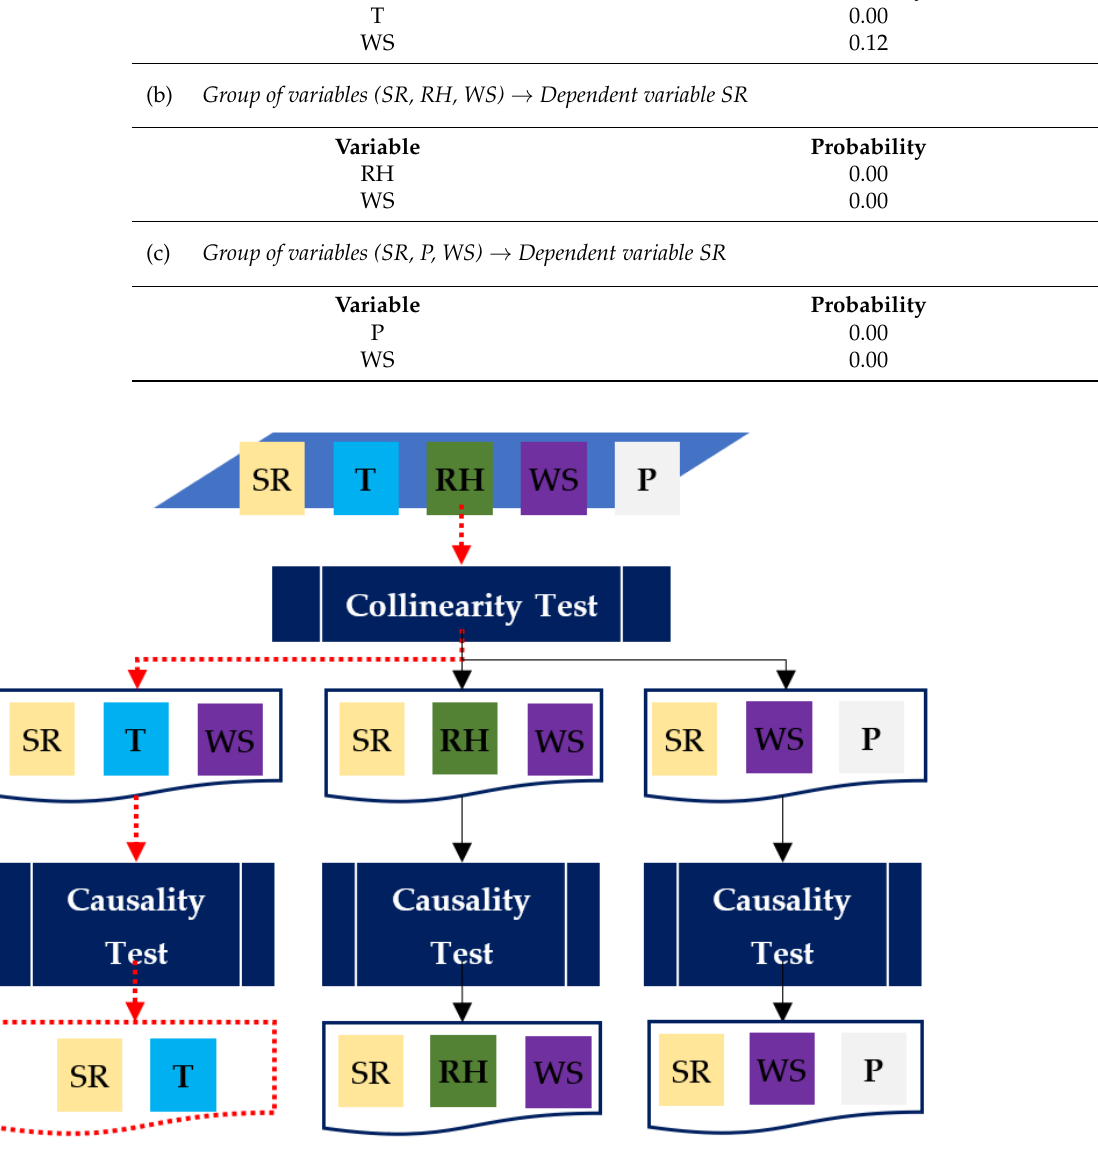
Figure 6. Output variables after applying the causality